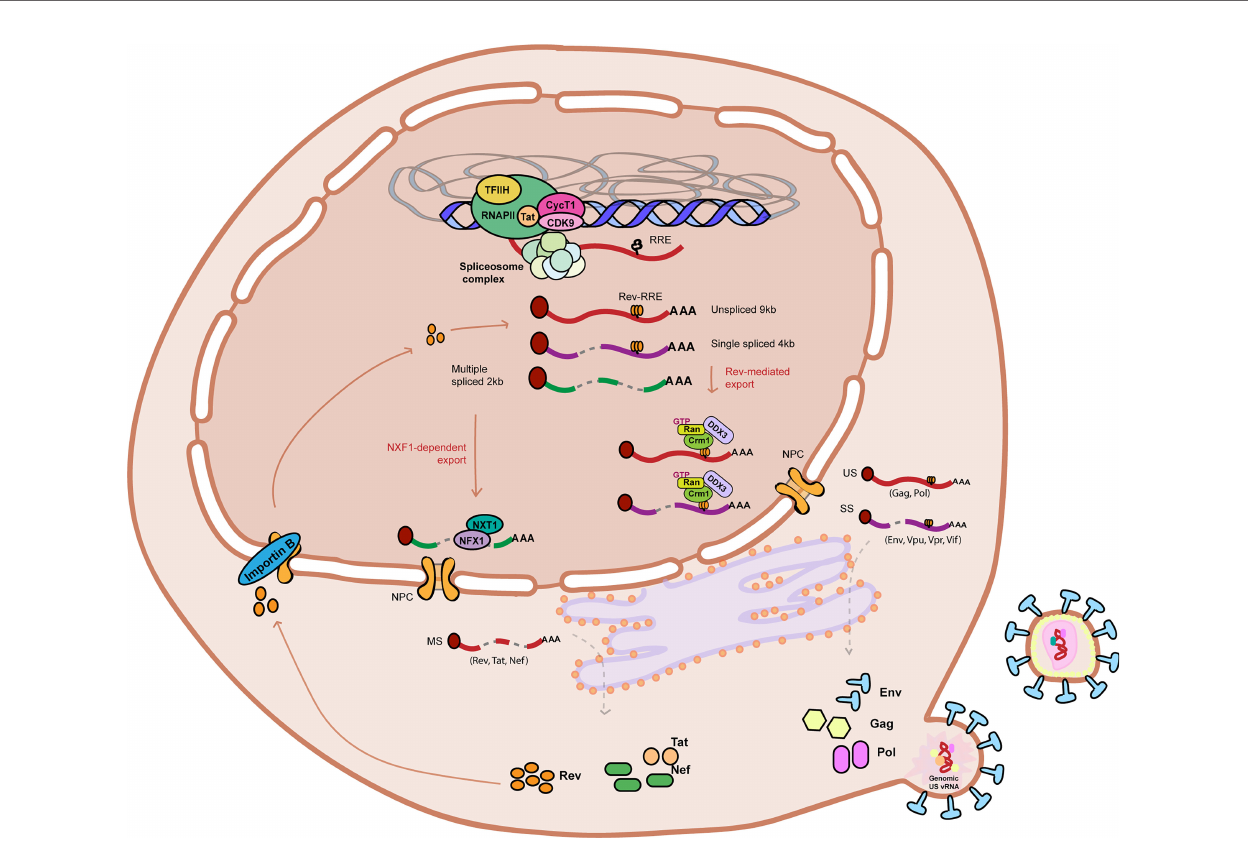
FIGURE 1 | Graphical representation of HIV-1 RNA metabolism and gene expression. HIV-1 RNA is actively transcribed from the HIV-1 promoter by the RNA Polymerase II in complex with Positive Transcription Elongation Factor B (PTEF-b) complex and viral protein Tat amongst other co-factors. Nascent viral RNA is processed co-transcriptionally upon 5 ’ capping (indicated by a red coloured circle at the beginning of the vRNA), recruitment of the host cell spliceosome machinery, and polyadenylation. The Unspliced (US) 9kb vRNA is subjected to alternative splicing and results in two other vRNA splicing variants: Single spliced (SS) 4kb vRNA and Multiple spliced (MS) 2kb vRNA. MS vRNA transcripts are exported via NXF1/NXT1-mediated export and translated in the cytoplasm to produce HIV-1 proteins Tat, Nef and Rev. Nucleocytoplasmic export of US and SS vRNA transcripts is dependent on Rev (imported to the nucleus by Importing B) binding to the secondary RNA structure RRE. Multiple Rev molecules multimerize and bind RRE-containing US and SS vRNA transcripts and recruits host cell protein CRM-1 to form an RNP containing other host cell proteins such as Ran-GTP and DDX3, promoting its export into the cytoplasm. US and SS vRNA transcripts are translated in the cytoplasm to produce, respectively, Gag and Pol polyproteins and envelope protein Env and accessory proteins Vpu, Vpr and Vif. Viral assembly, budding and maturation are the last steps of the HIV-1 life cycle. Unspliced 9kb viral RNA is represented as a red curved line. Single spliced 4kb viral RNA is represented as a partially cut purple curved line. Multiple spliced 2kb viral RNA is represented as a partially cut green curved line. RRE stands for Rev response element. NPC stands for nuclear pore